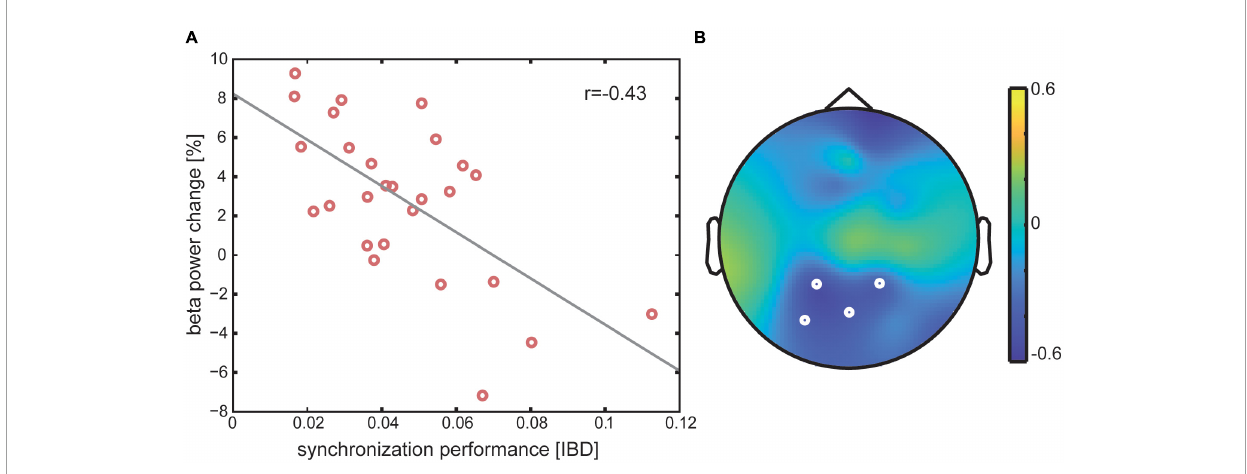
FIGURE3 Sensory-motor interaction: Panel (A) correlation between pre-stimulus beta power change in percent in the rhythmic pedaling condition and synchronization performance as measured by the IBI deviation. Panel (B) topographical distribution of the rho-values of the negative cluster for the respective correlation in the significant time window from –406 to –382 ms. White circles indicate electrode sites that belong to the significant